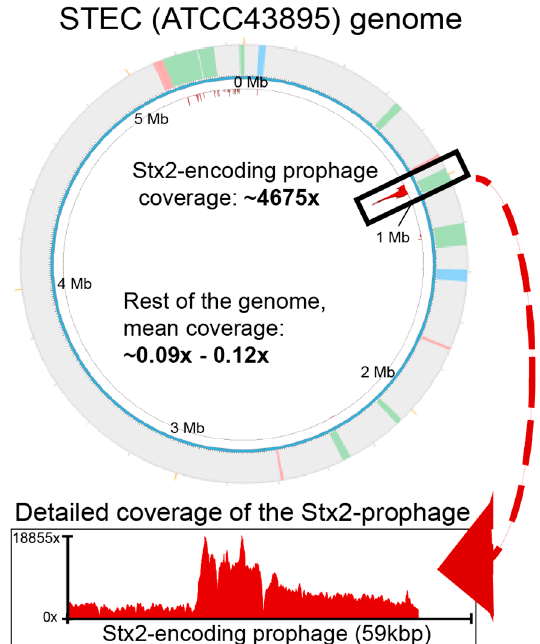
Figure 1. Phage 933W is the only prophage that is spontaneously induced. Shown here is the read mapping from sequenced Escherichia coli (STEC) cultures in biological triplicates. The circular plot represents the host genome, with the PHASTER-predicted prophages in colors (pink, red, or blue) in the outer circle, as well as the reads mapped to the entire genome. Prophage 933W is covered ~4675 times on average throughout its entire length, whereas the rest of the non-prophage and prophage genomic regions are covered, on average, 0.09 and 0.12 times, respectively. The prophage 933W region and read-mapping to such a region is amplified below the circular plot to show that the entire prophage length is covered by reads, and their proportion. Detailed information of the reads can be found in Table 1 and in the Supplementary Materials, Dataset.